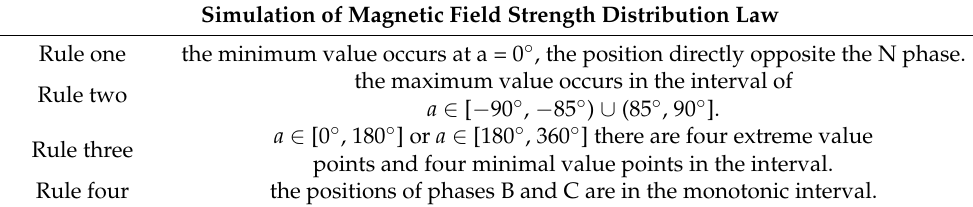
Table 2. Simulation result.